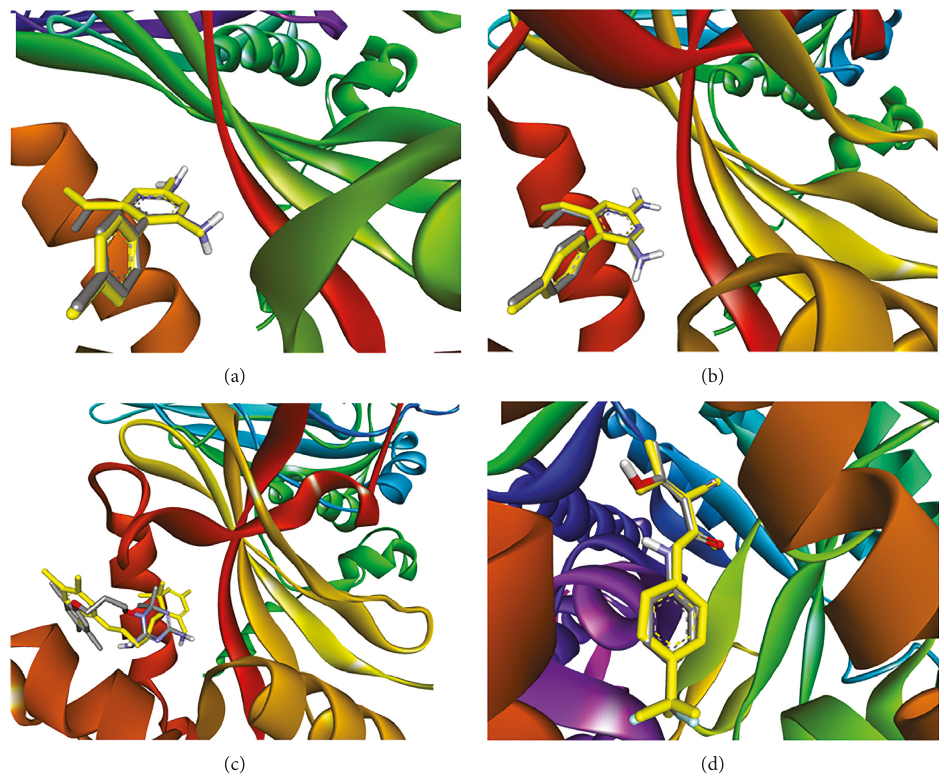
Figure 3: Superimposition of redocked ligands (in yellow) with the bound conformations of the ligands from the X-ray crystal structures (gray). (a) Pyrimethamine with wild-type Pf DHFR (3QGT); (b) pyrimethamine with double mutant Pf DHFR (1J3J); (c) WR99210 with quadruple mutant Pf DHFR (1J3K); (d) teriflunomide with Pf DHODH